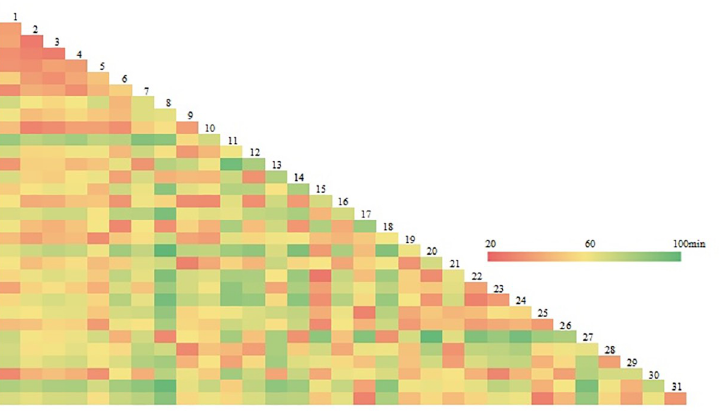
Fig 4. Matrix table of travel time between attractions after the integration of tourism